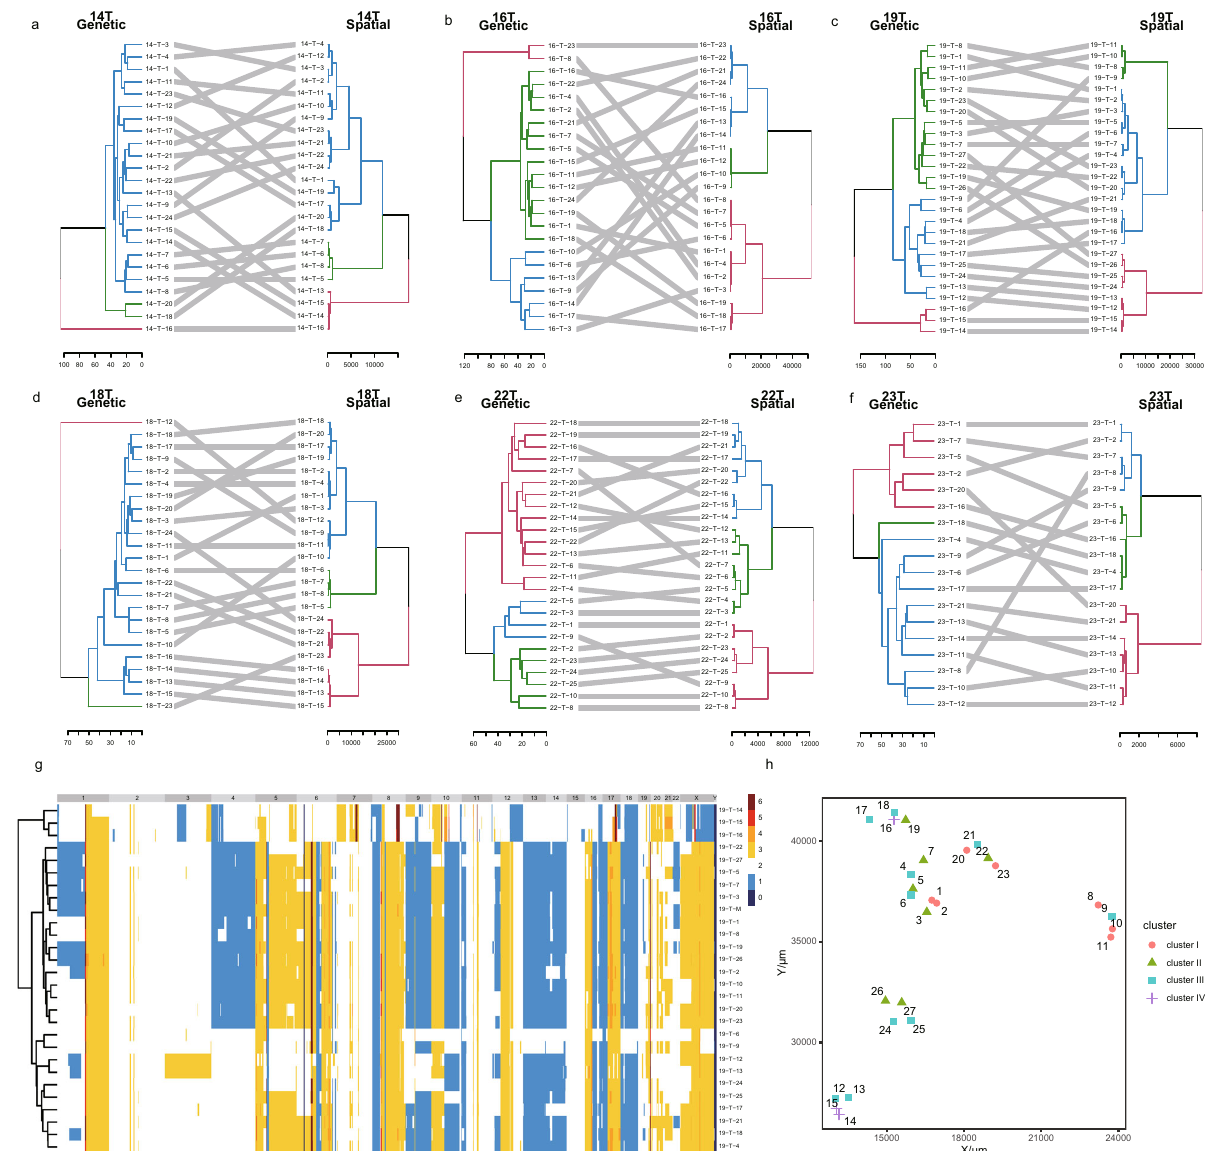
Fig. 5 Mapping of the spatial and genetic distances of single-cell clusters in primary tumors from six IMPC patients. a – f Genetic distance and spatial distance mapping tree of primary IMPC (P14, P16, P18, P19, P22, and P23). The spatial distance was obtained by establishing a coordinate system. The genetic distance was calculated by comparing the number of CNVs. The genomic tree is located on the left, and the different colors represent different clonal subpopulations. The spatial tree is located on the right, and the different colors represent the different regions. The mapping of cell cluster coordinates and genotypes was performed by minimizing the overlapping connections. g Heatmap of the copy-number pro fi les of single-cell clusters in P19. Unsupervised clustering based on CNV similarity between different single-cell clusters and the different evolutionary stages during which the cell clusters were isolated is indicated. The values on the right represent the copy number: ≤ 1 indicates a loss and ≥ 3 indicates a gain. h Tumor section pattern map of P19. A coordinate system for each slice was established to obtain the x -axis and y -axis information, and the spatial positional relationship of the cell clusters was extracted accordingly. The corresponding evolutionary period of the cell clusters is based on the clustering Two single clusters may belong to the same subclone subclones in the primary tumors that are highly similar to the (monoclonal metastatic seeds) or two different subclones subclones in the lymph node metastases. The T1, T2, T1, T2, T1, (polyclonal metastatic seeds) in primary tumors, in order to and T1 subclones, which were highly similar to the lymph node verify the evolutionary paths discussed above, we divided cell subclones, were selected from patients P14, P16, P18, P19, P22, clusters into different subclones. We speculate that monoclonal or and P23, respectively (Fig. 6b). Two lymph nodes originated polyclonal metastatic seeds that may be present in primary IMPC clusters of P18 belong to the T1 subclone. By analyzing the have a higher metastatic potential than other subclones with the genomic features of these subclones with high metastatic same genetic background. We tested this hypothesis by selecting 6 potential, we found that these subclones have high-frequency patients with IMPC (P14, P19, P23, P18, P16, and P22) and recurrent CNV features, such as the copy-number loss of IGSF9 analyzing the single-cell cluster sequencing data from primary and PRDM16 and gain of ALDH2 (Fig. 6c). Based on these data, tumors and the paired lymph node metastases to identify the CNVs in the IGSF9 , PRDM16 , and ALDH2 genes may be the key